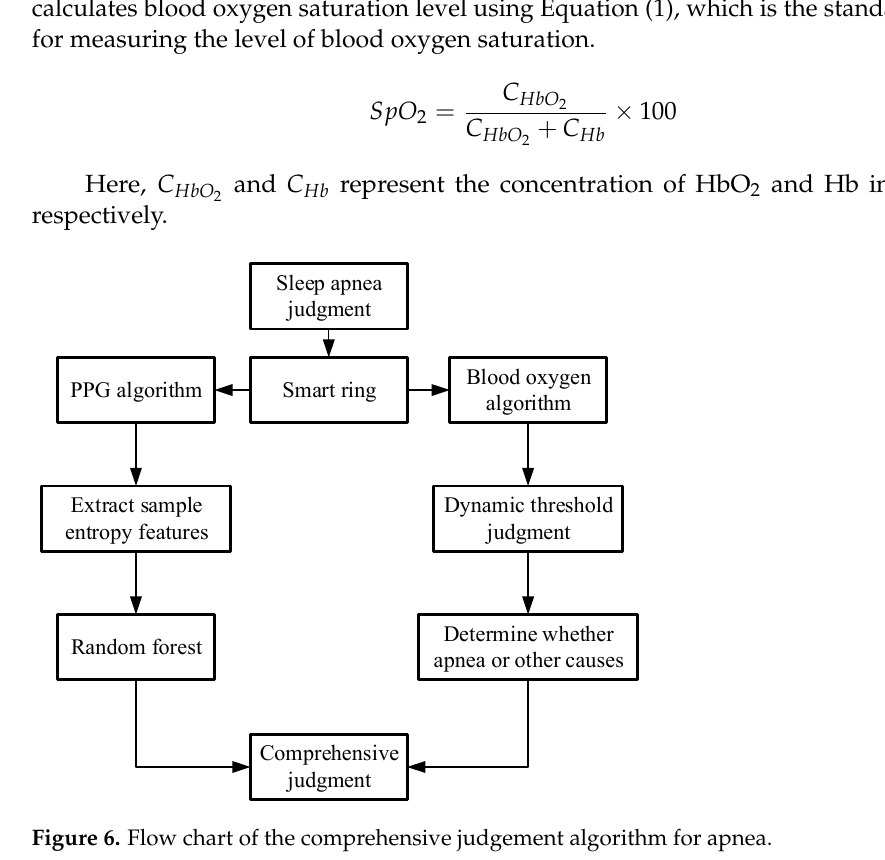
Figure 6. Flow chart of the comprehensive judgement algorithm for apnea.